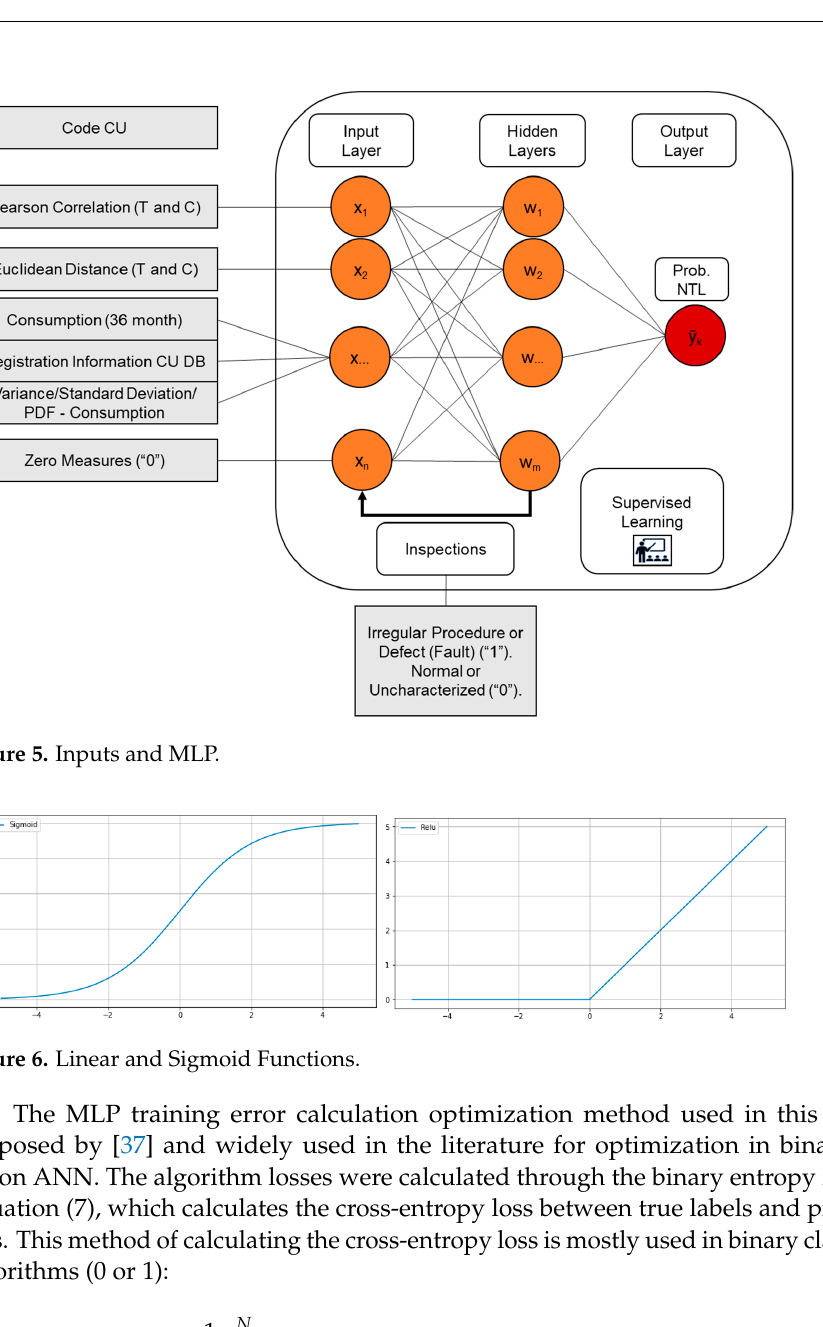
Figure 6. Linear and Sigmoid Functions.